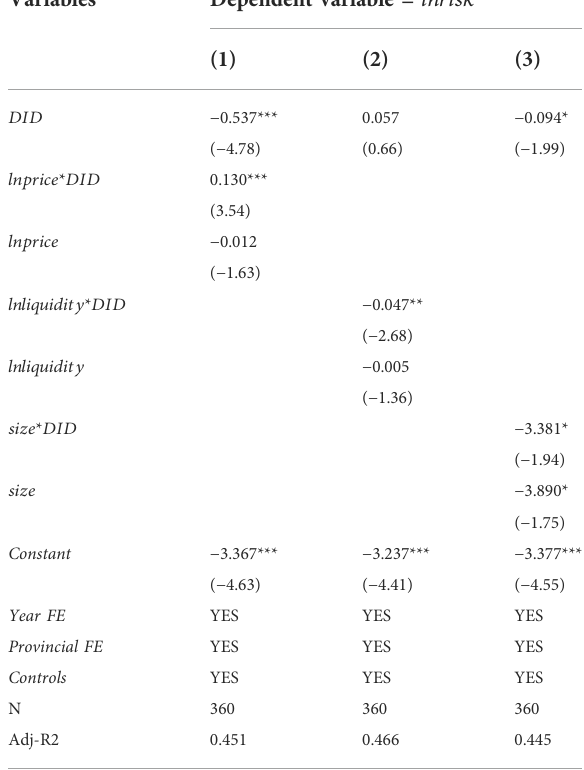
TABLE 5 Impact of the ef fi ciency of market operations on regional ecological